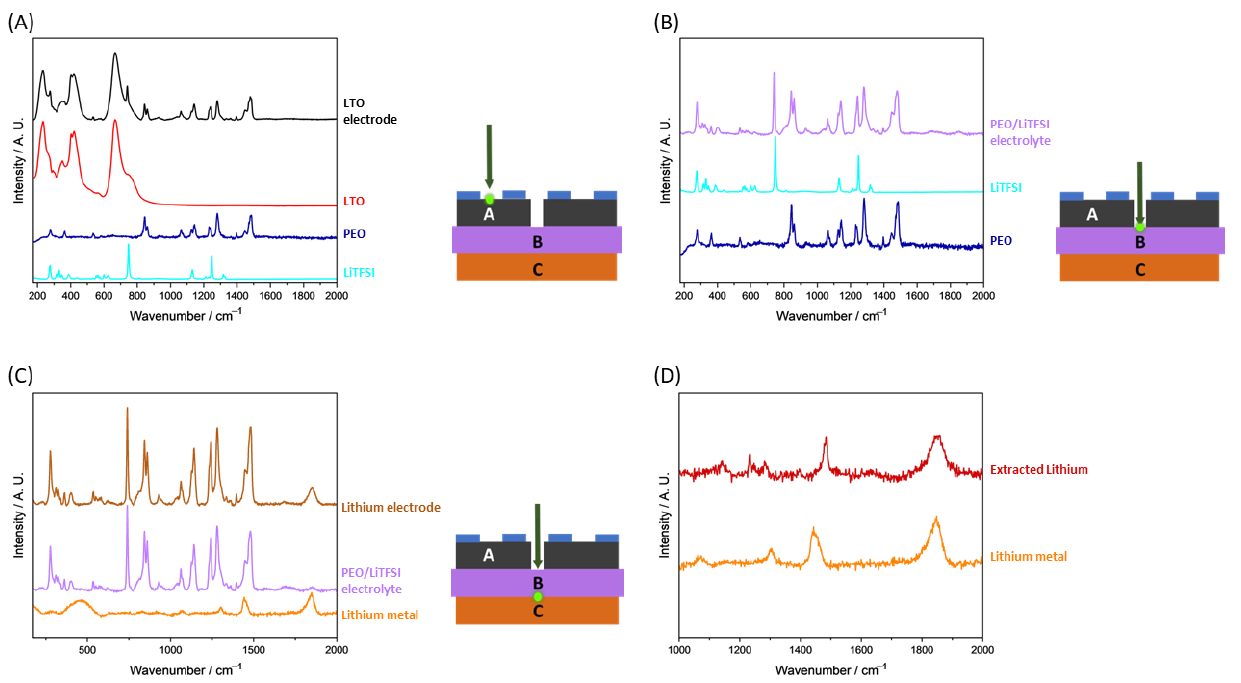
Figure 6. Raman spectra obtained from ( A ) the LTO electrode (black) and its constituents (electrode constituents: LTO, red; PEO, dark blue; LiTFSI, cyan); ( B ) the solid electrolyte (purple) and its constituents (solid electrolyte constituents: PEO, dark blue; LiTFSI, cyan); ( C ) the lithium metal surface through the solid electrolyte (lithium electrode, brown), the solid electrolyte (purple), and bare lithium metal surface (lithium metal, orange); ( D ) a comparison of the bare lithium metal surface (lithium metal, orange) and the extracted lithium contribution (extracted lithium, dark red).